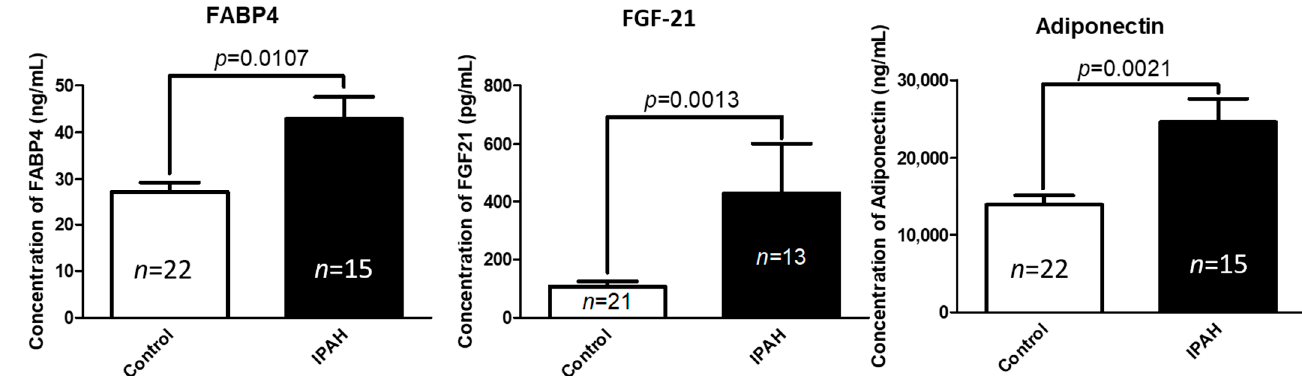
Figure 1. Circulating plasma fatty acid binding protein 4 (FABP-4), fibroblast growth factor -21 (FGF-21), and adiponectin levels are elevated in patients with IPAH compared to controls. Data represent mean ± SEM from n = 15–22 subjects per group (see Tables S1 and S2 for patient characteristics). Control: Normal controls, IPAH: Idiopathic Pulmonary Arterial Hypertension. Statistical analysis by Student’s t-test.